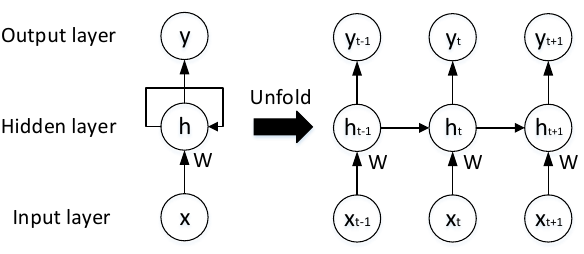
Figure 8. The structure of an